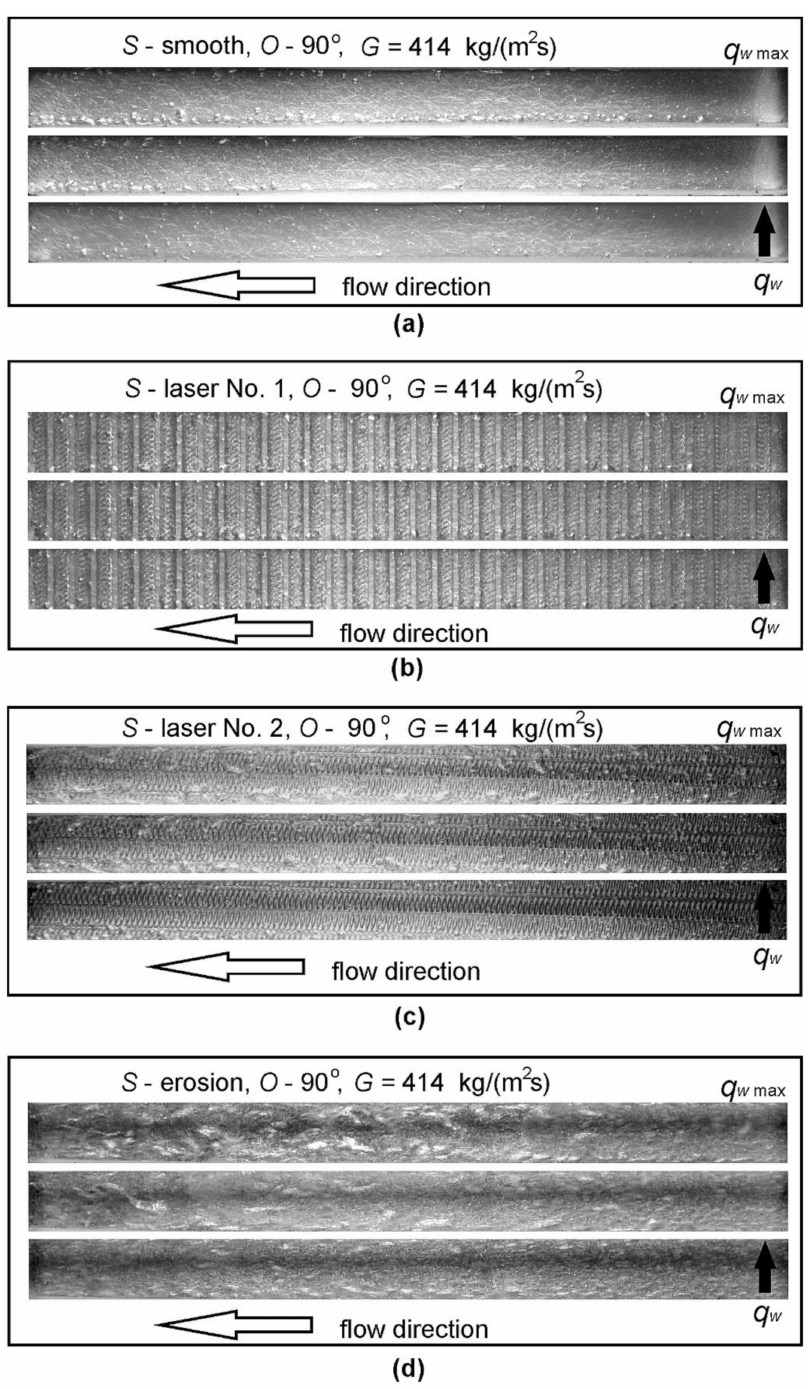
Figure 15. Images of two-phase flow structures recorded for: various modified heated plates, constant mass flux, vertical channel orientation (90 ◦ ), FC-72, L IRT = 180